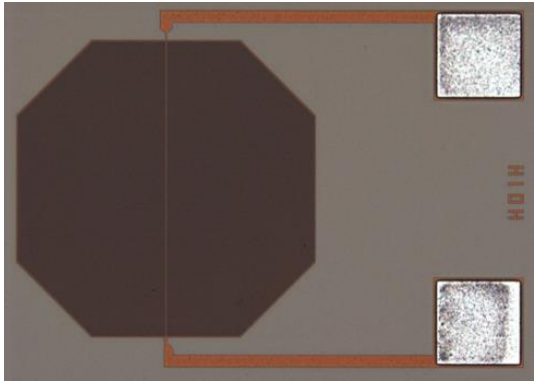
Figure 5. Top view photo of the fabricated sensor structure.